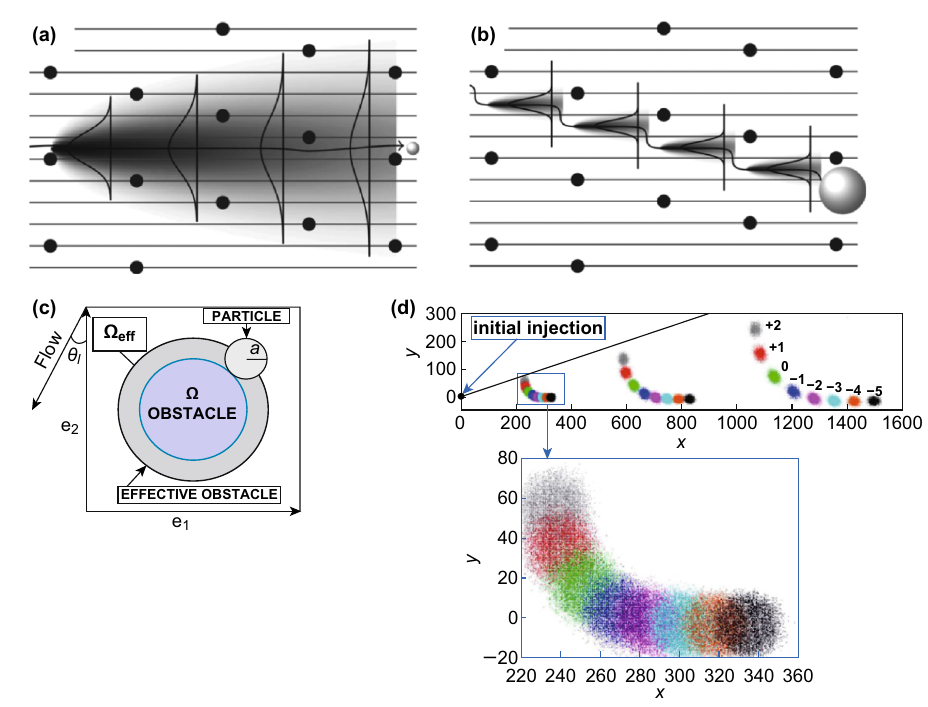
Fig. 8 a Motion probability for small particles, indicated by the shaded region, is controlled by diffusion. An ideal position of a non-diffusive particle is indicated by the solid black trajectory straight line [59]. b Large particles have more dominated by the lateral displacement and are slightly affected by diffusion [59]. c Illustration of the effective obstacle concept. The blue area is the actual obstacle size, and the dark gray area represents the effective obstacle, which is the actual side of the particle [61]. d Chromatographic separation of particles with eight characteris- tic sizes in DLD under transient condition [55]. Figure panels reproduced from Ref. [59] with permission from IOP Publishing Ltd., copyright 2008, Ref. [61] with permission from Springer, copyright 2013, Ref. [55] with permission from Springer, copyright 2019. (Color figure